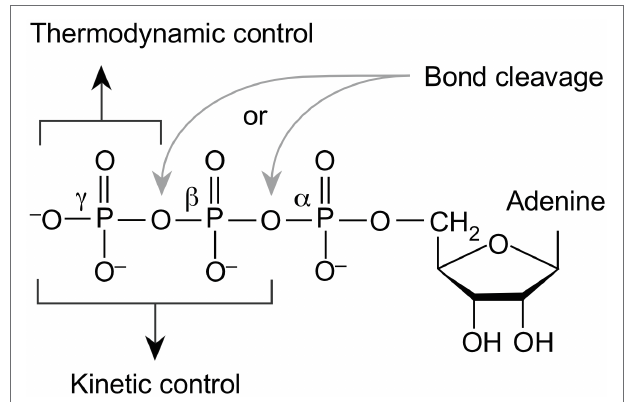
FIGURE 2 | Role of nucleoside triphosphates in metabolic evolution. Coupling of ATP hydrolysis to P i and ADP or to phosphorylation releases − 32 kJ·mol − 1 under standard physiological conditions, shifting the equilibrium of otherwise mildly endergonic reactions in the direction of product formation. Such reactions are under thermodynamic control, the products are more stable than the educts, but such reactions are usually reversible under physiological conditions of the cell, unless ∆ G is very large. Coupling of ATP hydrolysis to PP i and AMP or to adenylation releases − 45 kJ·mol − 1 under standard physiological conditions, similar to the free energy change for acyl phosphate hydrolysis, but the ubiquitous presence of pyrophosphatase activity in cells leads to immediate PP i hydrolysis, such that a product for the reverse reaction is removed. Even if the reverse reaction was thermodynamically favorable, it cannot take place because an educt (PP i ) is lacking, making the reverse reaction orders of magnitude slower than the forward reaction, placing it under kinetic